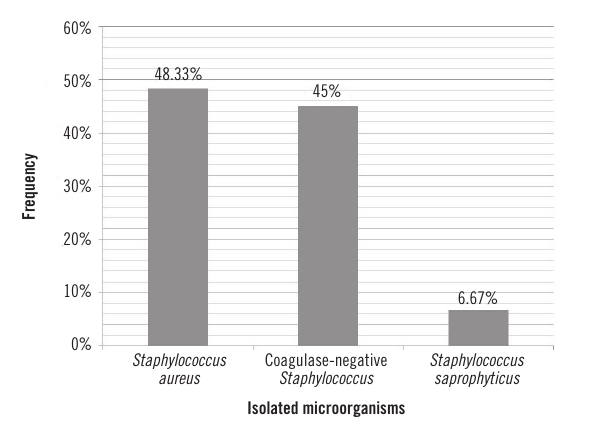
figurE 1 − Frequency of microorganisms isolated from the analyzed blood cultures